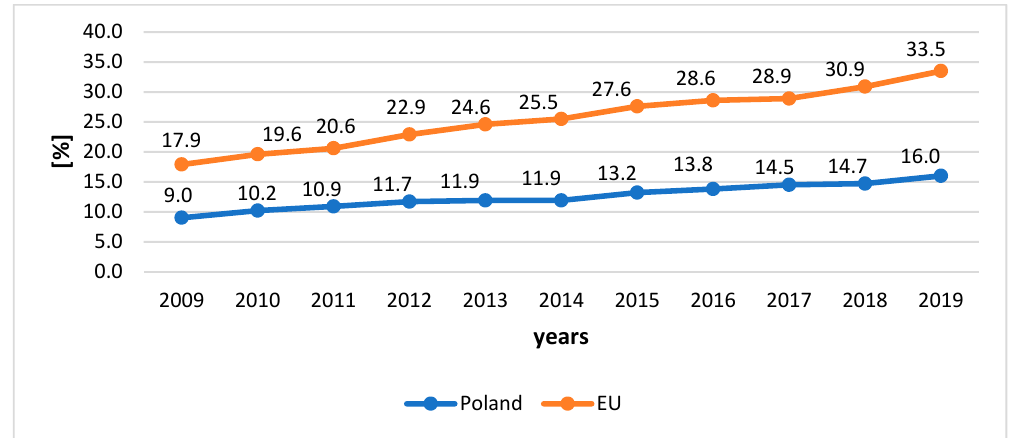
Figure 1. Share of energy from renewable sources in total primary energy in the years 2009–2019 [%]. Source: [8–10].